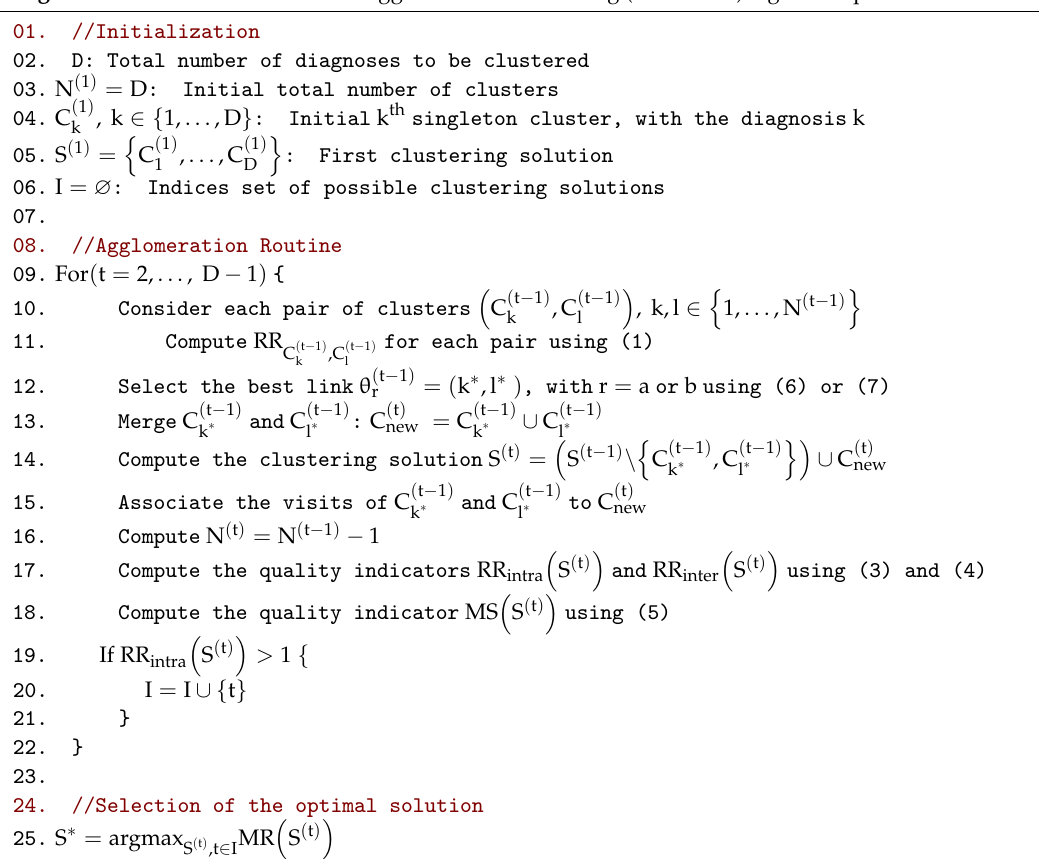
Algorithm 1 The new Hierarchical Agglomerative Clustering (HAC-cooc) algorithm